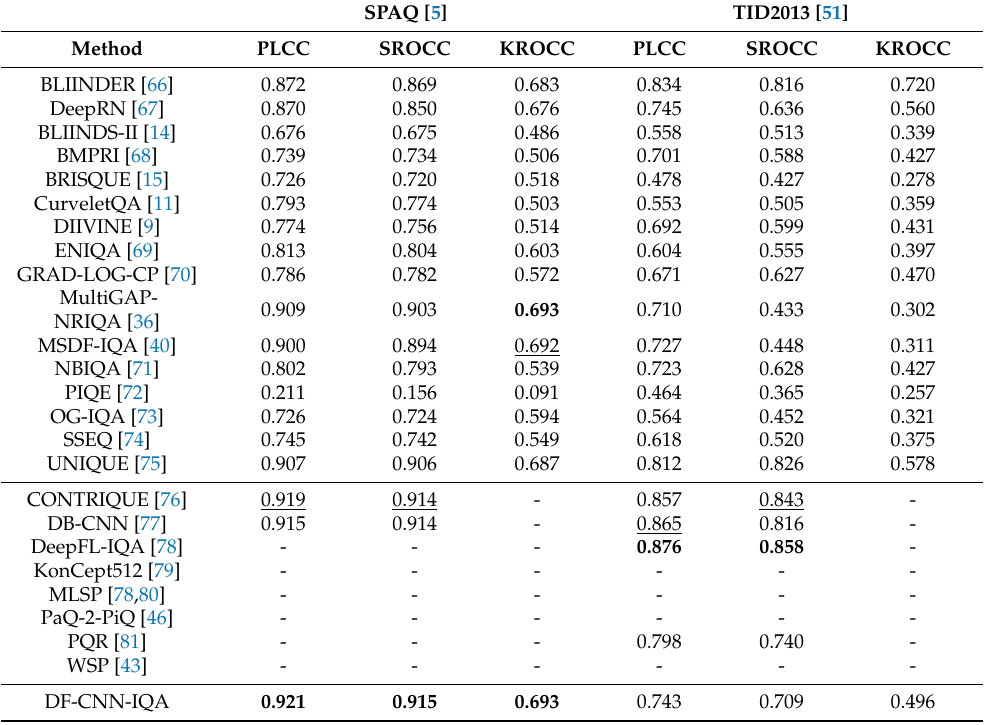
Table 5. Comparison of DF-CNN-IQA to the state of the art on SPAQ [5] and TID2013 [51]. Median PLCC, SROCC and KROCC values were measured over 100 random train–validation–test splits. The best results are typed in bold , and the second-best results are underlined. We denoted by ‘-’ if the data were not